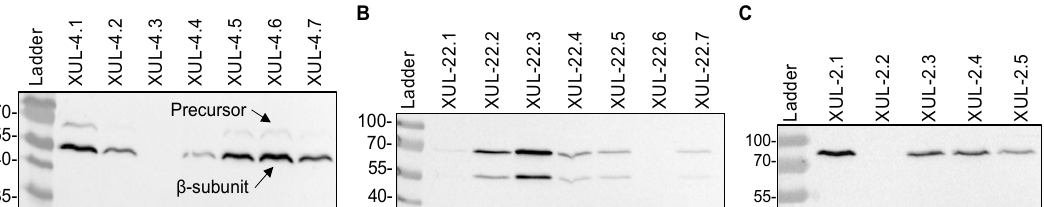
Figure 3. Western blot analysis to detect recombinant CCAs (CCAA, CCAB, and CCAC) fused to the HA-tag in A. chrysogenum transformants as indicated. ( A ) Detection of CCAA in mycelial extracts. The protein bands of CCAA precursor (79 kDa) and β -subunit (60 kDa) are marked. ( B ) Detection of CCAB in mycelial extracts. ( C ) Detection of CCAC precursor in mycelial extracts.